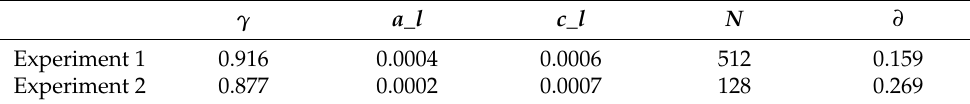
Table 3. Results of AutoML optimization hyperparameters under different experiments.